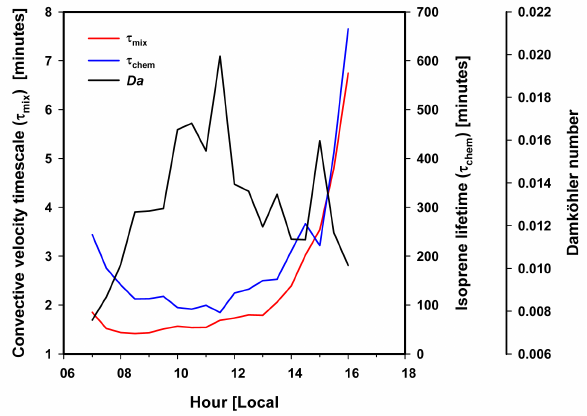
Fig. 3. The average boundary layer convective mixing velocity timescale ( τ mix ) and isoprene lifetime ( τ chem ) for the period 2– 21 July 2008 above a tropical rainforest. The Damk ¨ ohler number (black line) indicates the amount of isoprene that would be lost to chemical reaction before detection by our measurement system, which was located at 100–150m above the forest canopy top. Be- cause the GAW tower is located on a hill it is not possible to give a more precise measurement